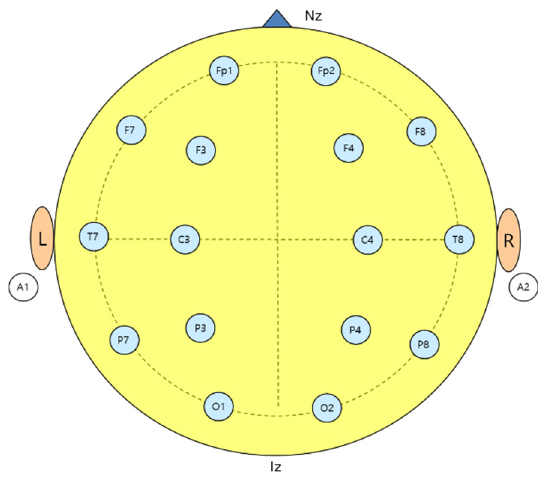
Figure 3. Image of electrode locations for EEG test. Table 5. Specifications of the EEG measurement device.